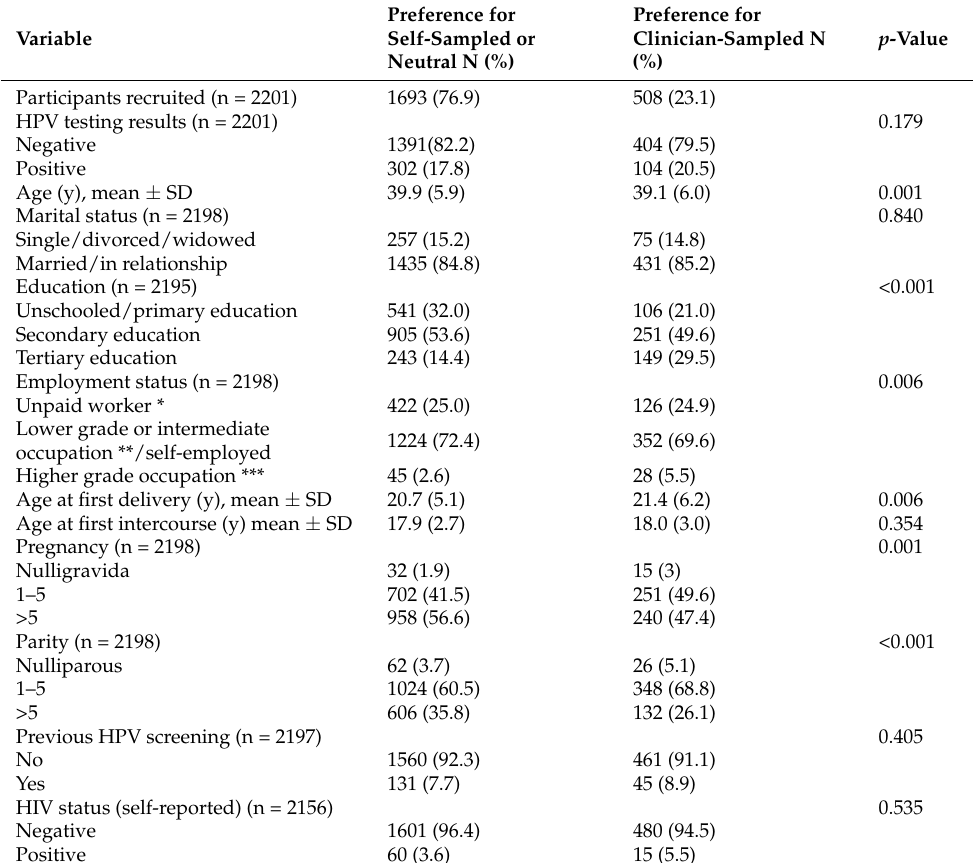
Table 1. Baseline sociodemographic and clinical characteristics according to preference for clinician- sampled or self-sampled HPV